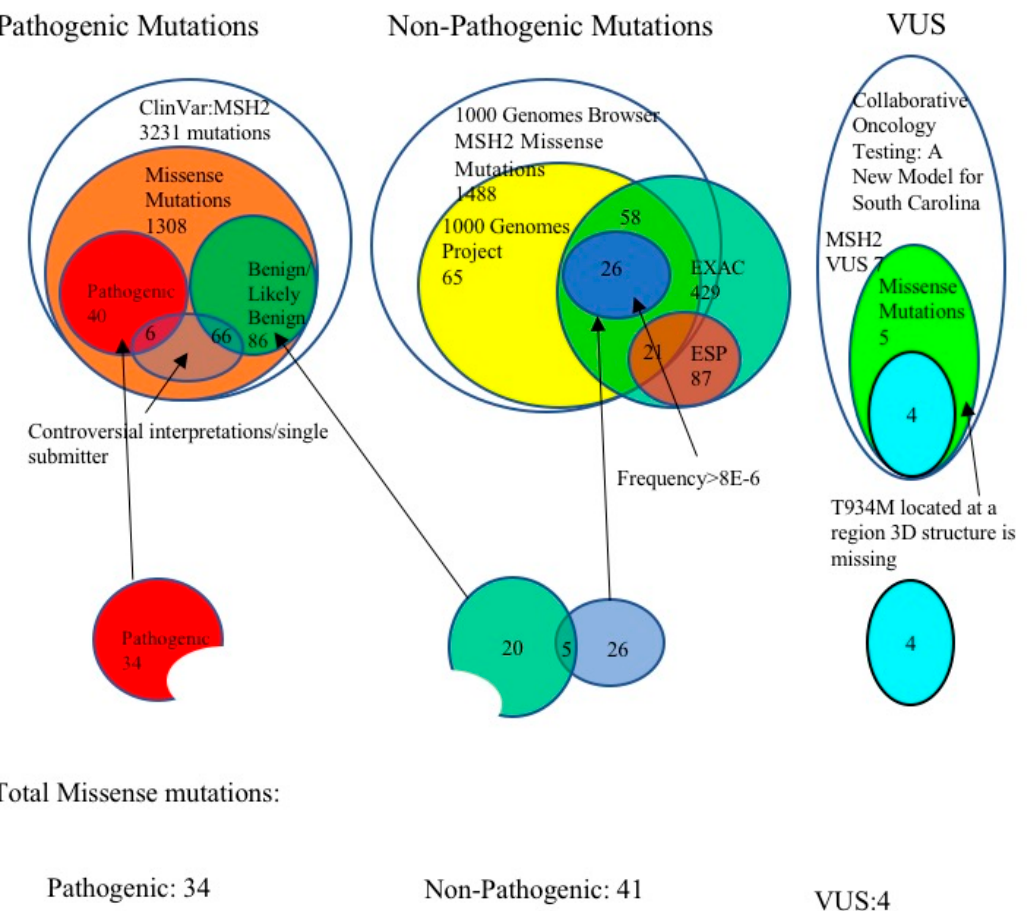
Figure 4. The selection procedures for pathogenic, non-pathogenic and VUS MSH2 Mutations. Pathogenic mutations were retrieved from the ClinVar database, non-pathogenic mutations were retrieved from the 1000 Genomes project with EXAC database and ESP database; and VUS mutations were from the research project, “Collaborative Oncology Testing: A New Model for South Carolina”.